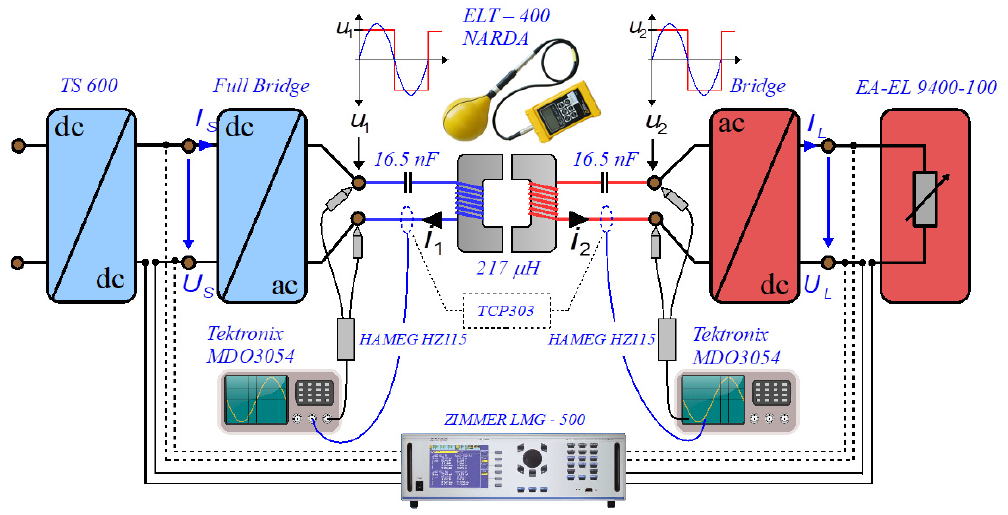
Figure 13. Schematic diagram of laboratory